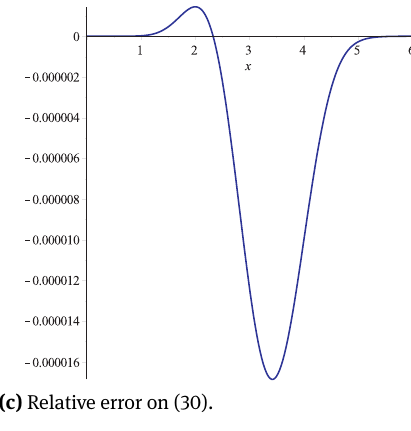
Figure 7: Comparison of CDF and its